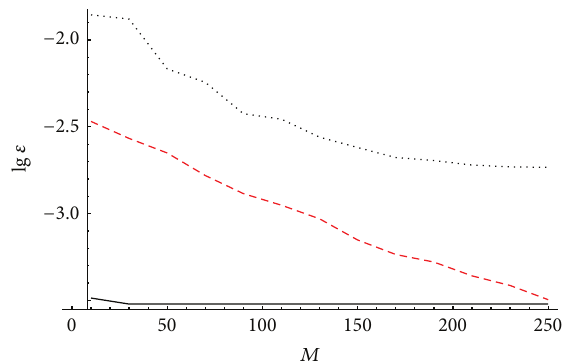
Figure 4: The relative error of reconstruction of 𝑛 2 (𝑥) for the parabolic layer versus the number of iterations 𝑀 . Refractive index is continuous in the whole domain. The solid curve corresponds to reconstructing frequencies 23–25 THz, the red dashed curve corresponds to reconstructing frequencies 50–52 THz, and the dotted curve corresponds to reconstructing frequencies 70–72 THz.